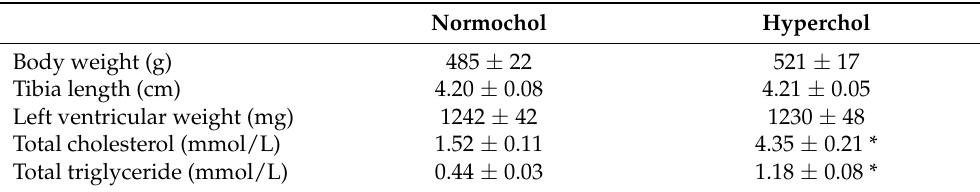
Table 1. Cholesterol-enriched-diet-induced high blood cholesterol. General characterization of normocholesterolemic (Normochol) and hypercholesterolemic (Hyperchol) rats after the 8-week diet period. * p < 0.05; n =